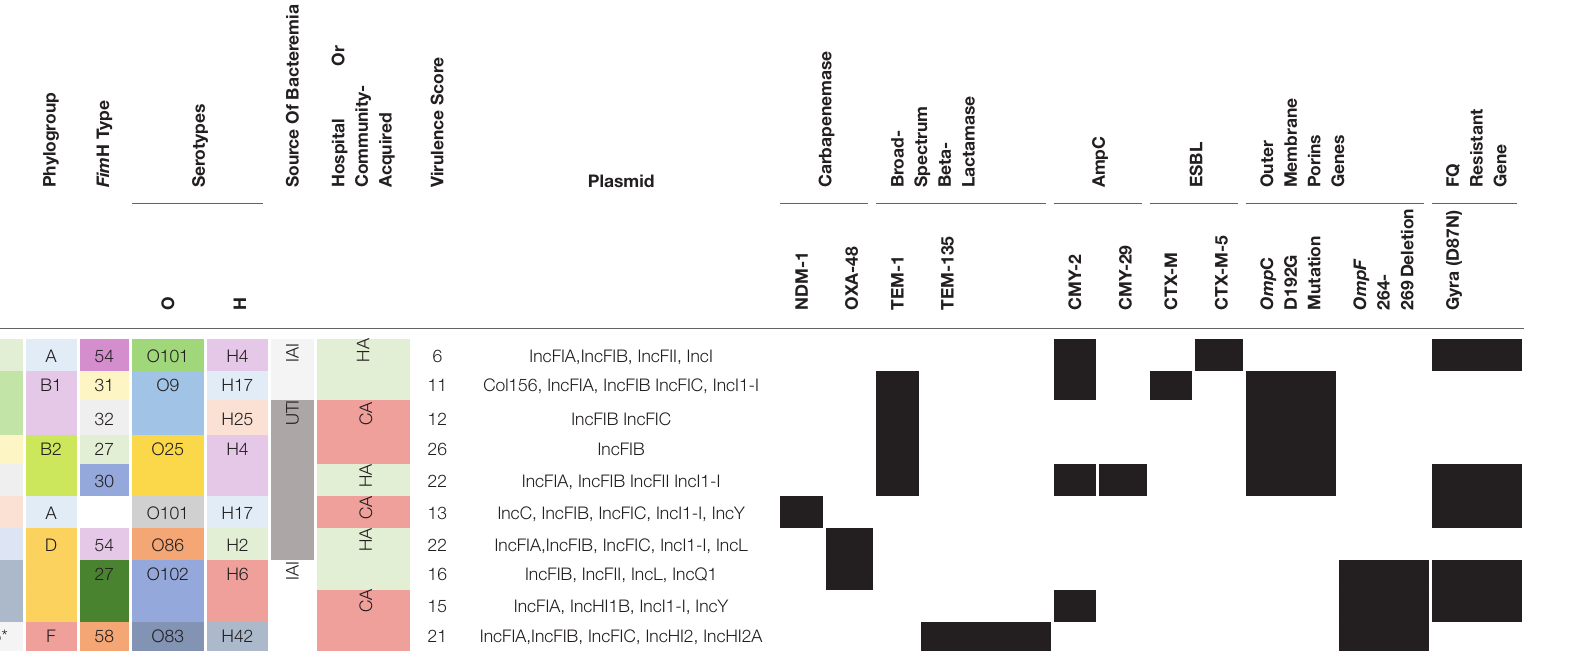
TABLE 2 | Genetic diversity, source of bacteremia, and antibiotic-resistant mechanisms identified in the E. coli strains.